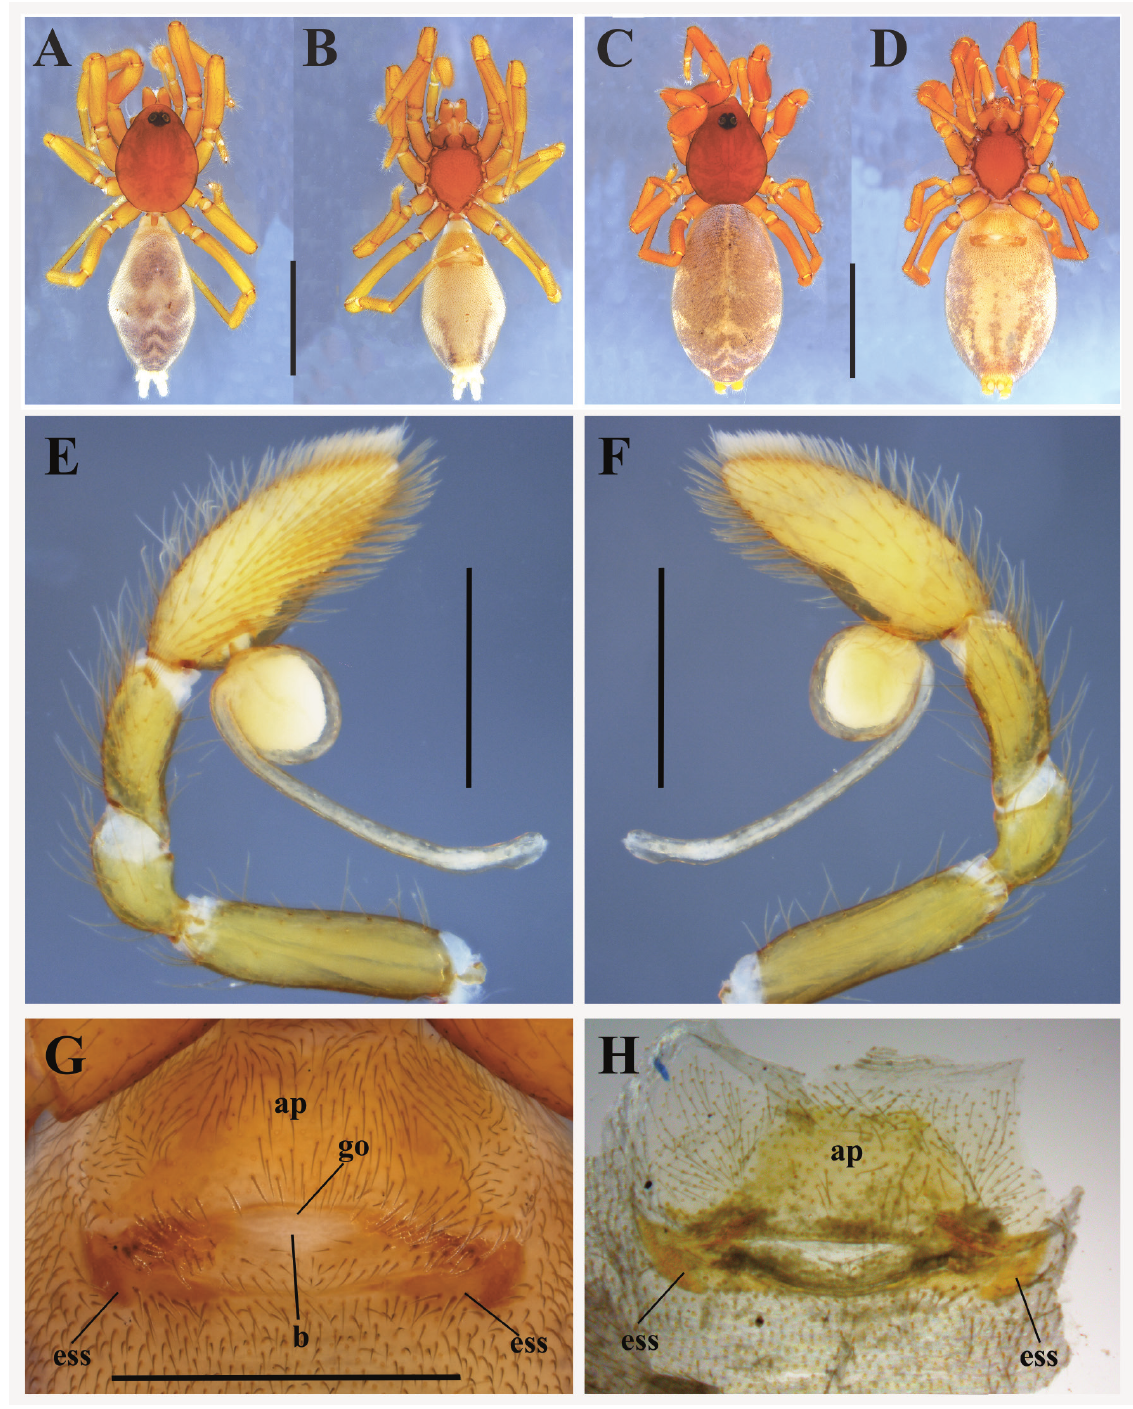
Fig. 2. Medionops carolinae sp. nov. A–B, E–F . Holotype, ♂ (IAvH-I 3782). C–D, G–H . Paratype, ♀ (IAvH-I 3771). A . Habitus, dorsal view. B . Habitus, ventral view. C . Habitus, dorsal view. D . Habitus, ventral view. E . Left palp, retrolateral view. F . Left palp, prolateral view. G . External genitalia, ventral view. H . Internal genitalia, dorsal view. Scale bars: A–D = 1.5 mm; E–F = 0.7 mm; G = 0.5 mm; H = 0.2 mm. Abbreviations: ap = anterior plate; b = area below genital opening; ess = external sclerotization around spiracles; go = genital